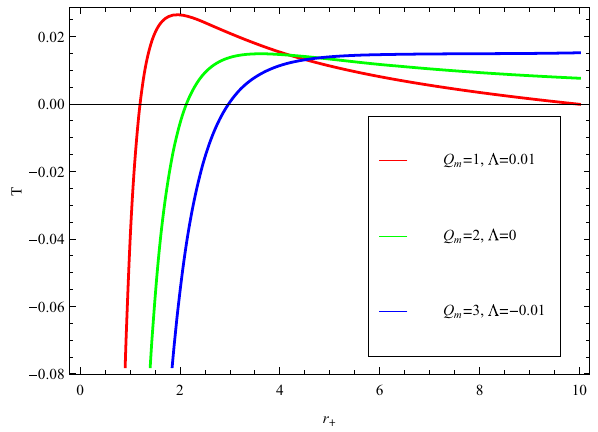
Fig. 1 Plot of temperature versus horizon radius at the fixed values of magnetic charge of the non-minimal